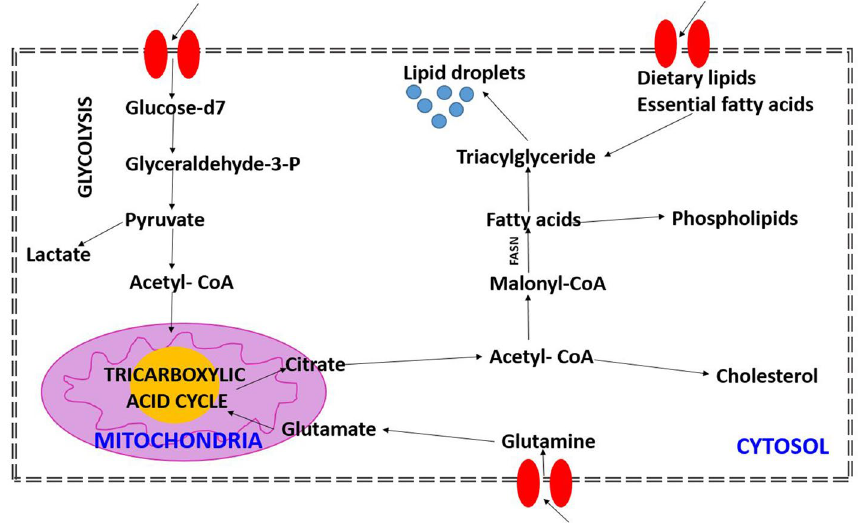
Figure 8. Glucose –derived de-novo lipid synthesis in mammalian cells.